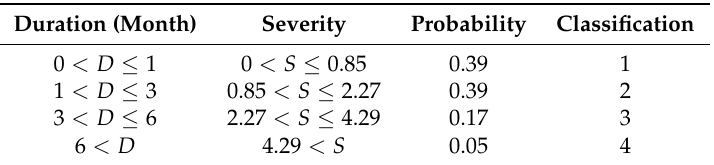
Table 1. Classifications of drought duration and